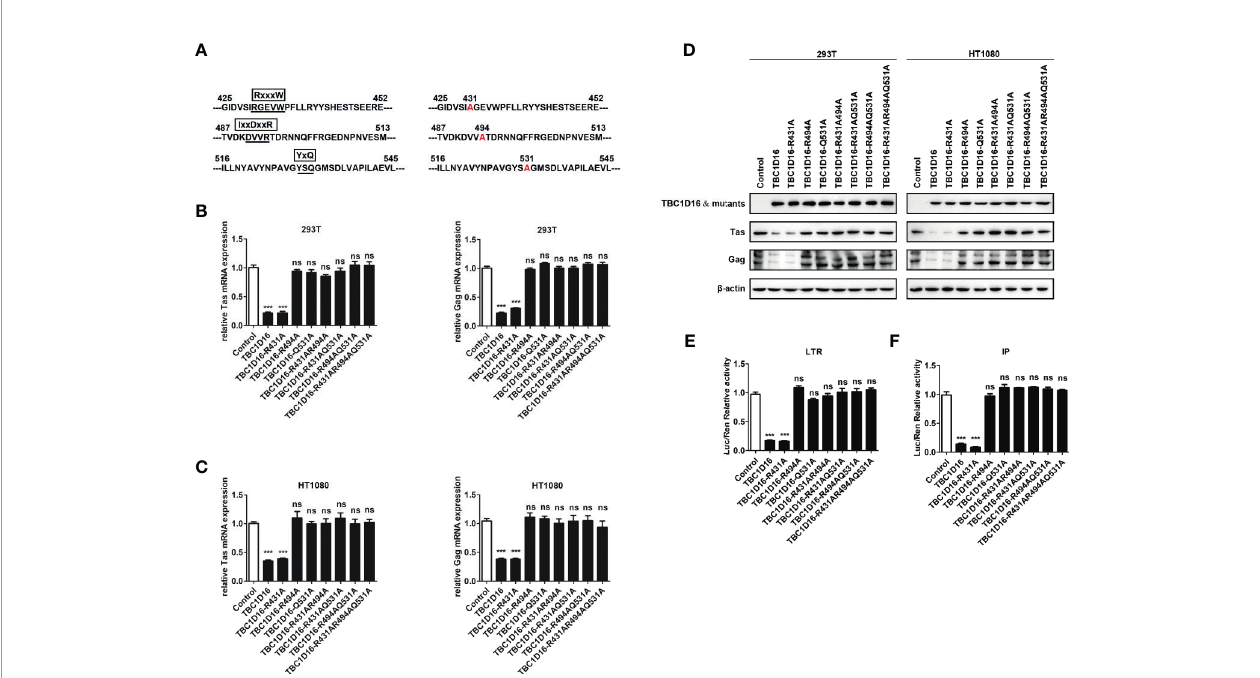
FIGURE 5 | Highly conserved amino-acid residues R494 and Q531 in the TBC domain are important for TBC1D16 to inhibit PFV replication. (A) Schematic diagram of the key locus in the TBC domain of TBC1D16 indicating three signature motifs, which were speci fi c locus mutants used in subsequent analyses. (B, C) pCMV- Flag-TBC1D16 speci fi c locus mutant plasmids (pCMV-Flag as an empty control) were transfected into HEK293T and HT1080 cells for 24 h. After transfection, cells were infected with PFV (MOI = 0.5) for 48 h. The mRNA expression of PFV Tas and Gag was detected by qPCR (*** p < 0.001 and ns no signi fi cance). (D) pCMV- Flag-TBC1D16 speci fi c locus mutant plasmids (pCMV-Flag as an empty control) were transfected into HEK293T and HT1080 cells for 24 h. After transfection, cells were infected with PFV (MOI = 0.5) for 48 h. The protein expression of PFV Tas and Gag was detected by western blot. (E, F) pCMV-Flag-TBC1D16 speci fi c locus mutant plasmids (400 ng and pCMV-Flag as an empty control), pRL-TK (3 ng), pTK-Tas (30 ng for pGL3-PFV-LTR-luc or 20 ng for pGL3-PFV-IP-luc) and pGL3- PFV-LTR-luc (30 ng) or pGL3-PFV-IP-luc (20 ng) fi re fl y luciferase reporter plasmid were cotransfected into HEK293T cells for 48 h. Luciferase reporter assay was used to detect LTR and IP promoter activity (Renilla luciferase as an internal control) (*** p <